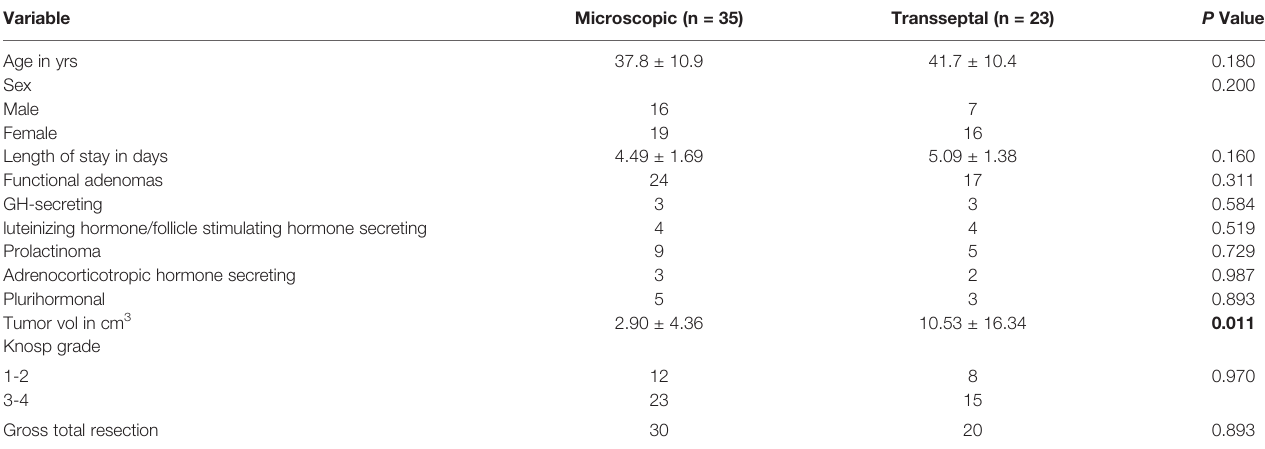
Values represent mean ± standard deviation. Bold values: statistically signi fi